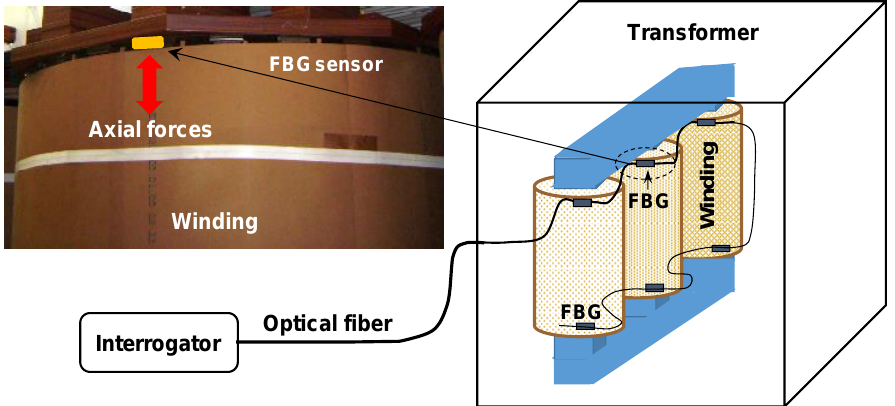
Figure 1. Winding deformation sensing system conception showing how the Fiber Bragg Grating (FBG) sensors are fixed in the in the outer winding and in outer structure, due to ease of installation in these points.